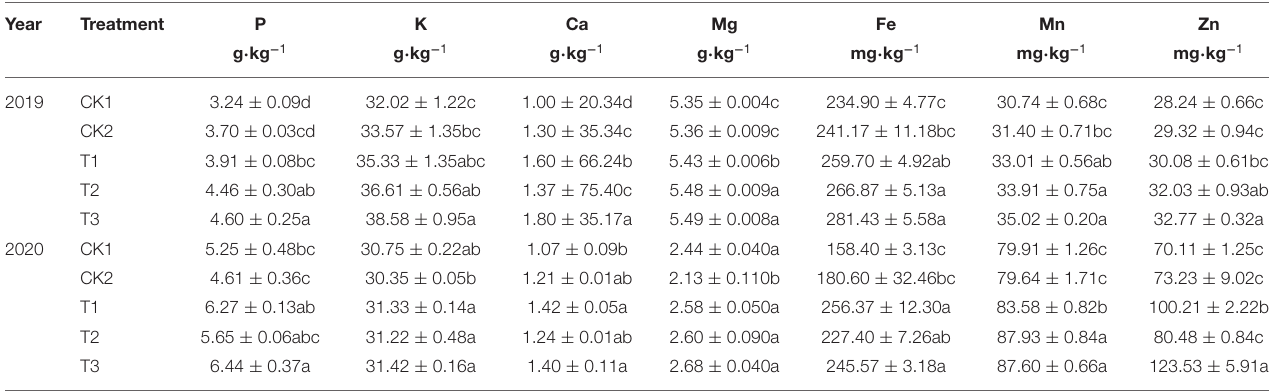
TABLE 4 | Effects of different ground mulching patterns on the mineral element content in loose-curd cauliflower heads. Year Treatment P